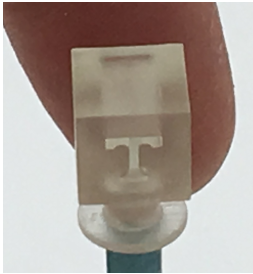
Figure 6. Photograph of 3D printed “Power T”